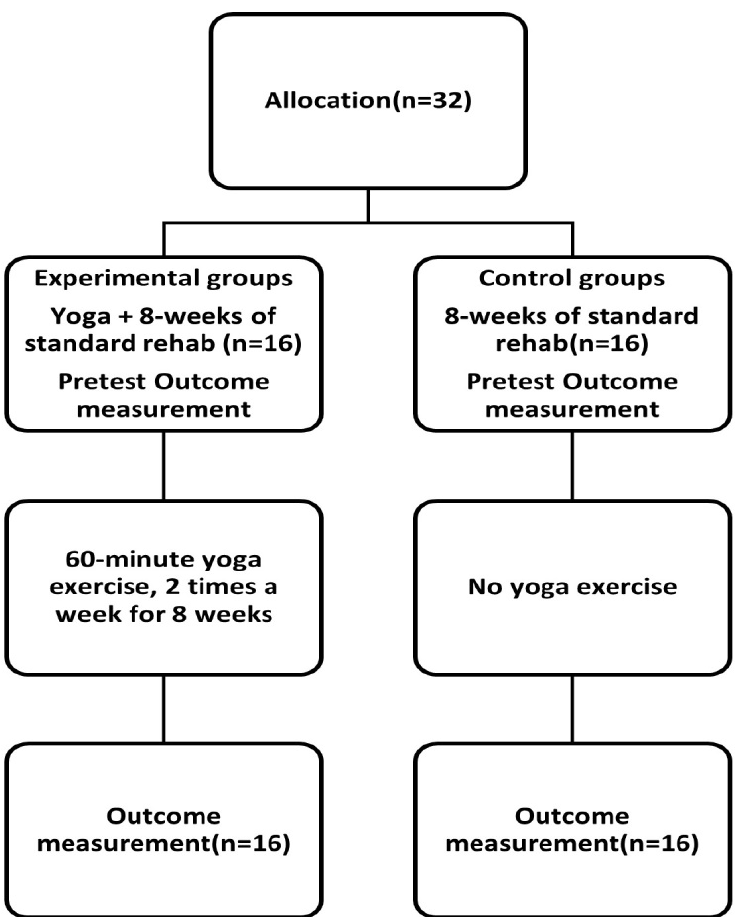
Figure 1. Flow diagram of the study.